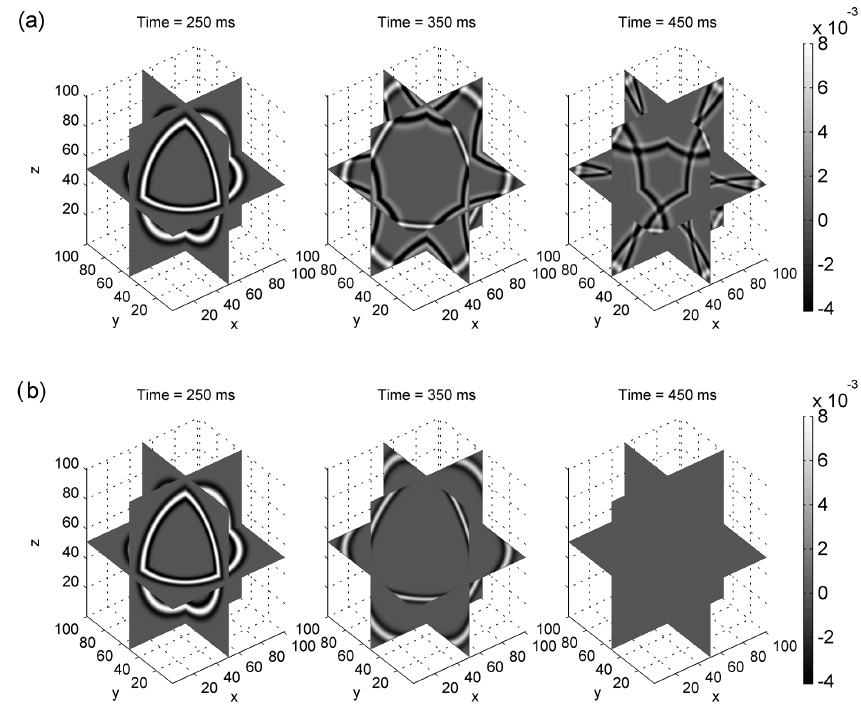
Figure 19. Wave field snapshots with different PML at different time; the three coordinate axes represent the number of grids in